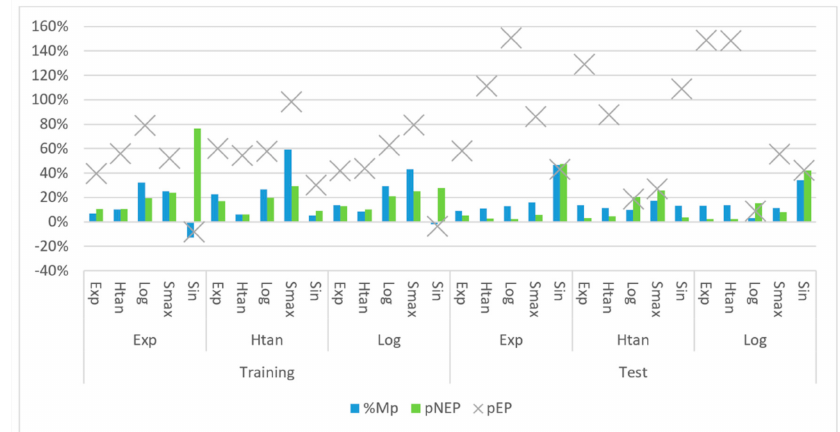
Figure 9. List for the best neural networks in accordance with the maximisation of pNEP indicator. Note: The number of neurons in the hidden layer ranged from 31 to 55.